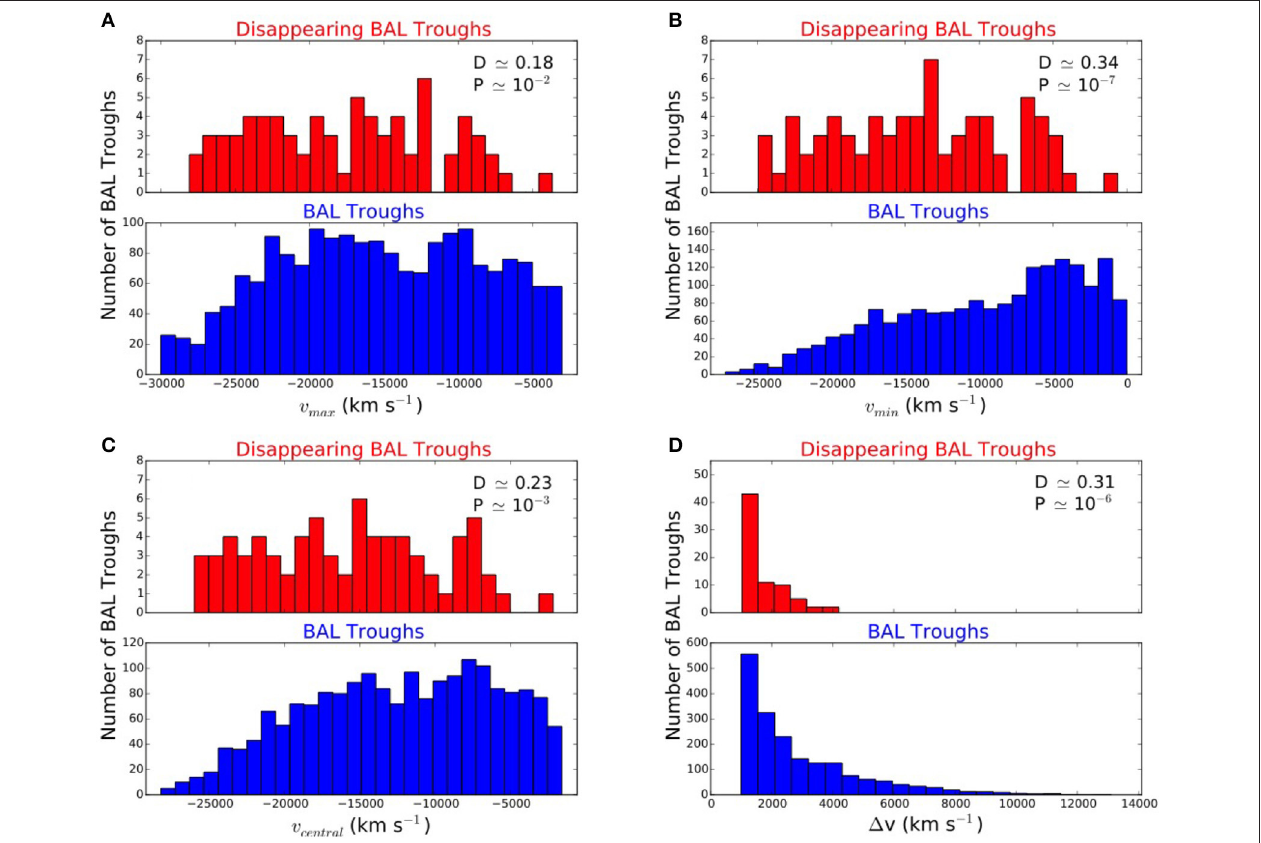
FIGURE 2 | Maximum observed velocity υ max (A) , minimum observed velocity υ min (B) , central velocity υ c (C) , and BAL width 1υ (D) distributions for the sample of disappearing BAL troughs (upper red histogram in each panel) and for the main sample of BAL troughs (lower blue histogram in each panel). Results of the Kolmogorov-Smirnov test performed on each pair of cumulative distributions are reported in each panel: D is the maximum distance between the two cumulative distributions, and P is the probability to get a higher D value assuming that the two datasets are drawn from the same distribution